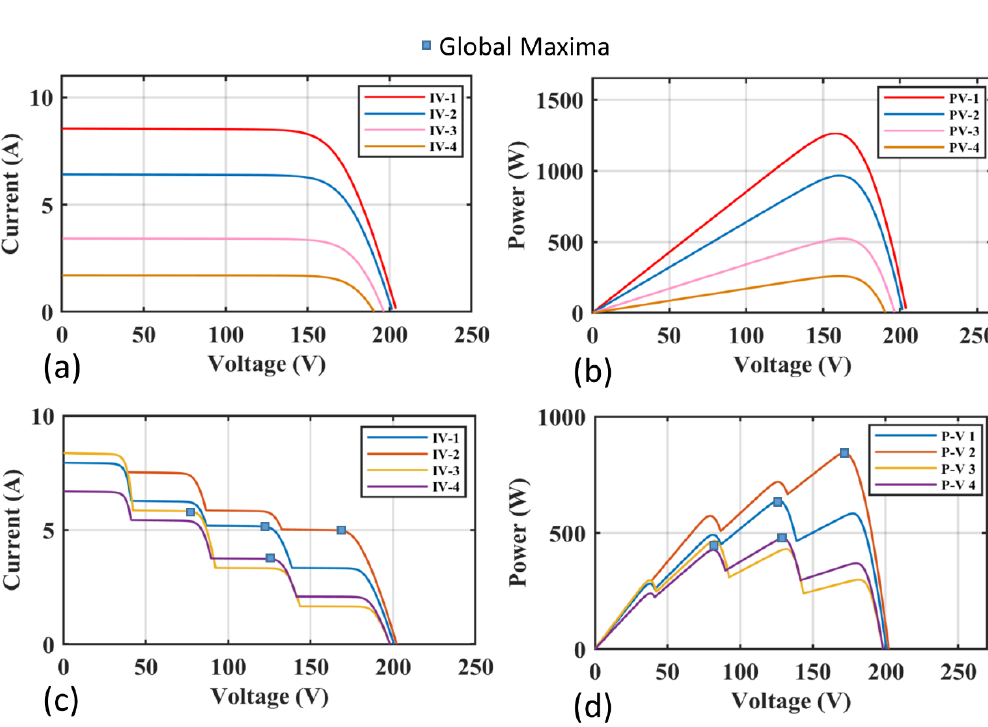
Figure 3. ( a ) Under uniform irradiance I–V curves. ( b ) Under uniform irradiance P–V curves. ( c ) Under non-uniform irradiance I–V curves. ( d ) Under non-uniform irradiance P–V curves.